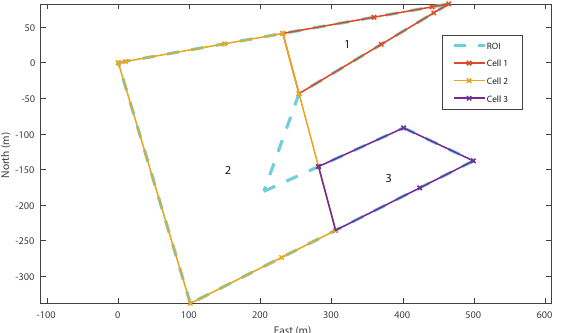
Figure 12. Cell merge preformed on the decomposed cells generated for Figure 11, where the merged cell number 2 contains the shortcut granted by combining normal and optional cells to make for a more efficient